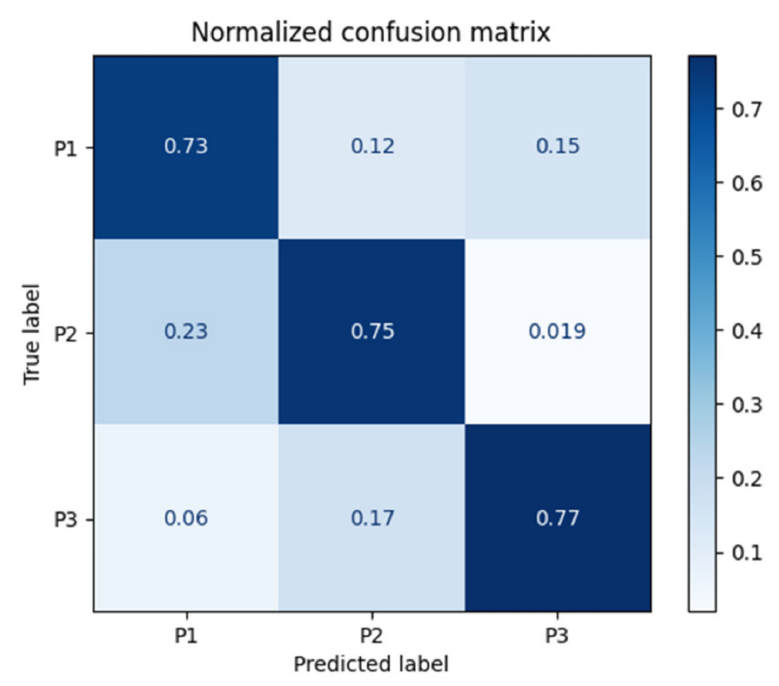
Figure 11. Confusion matrix for SVM classifier.